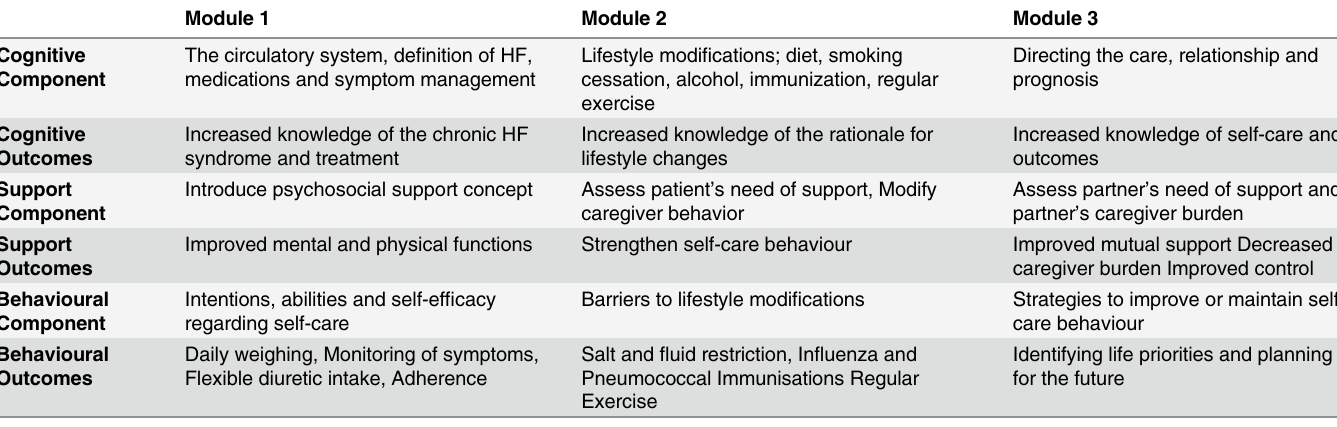
Table 1. Description of the modules in the